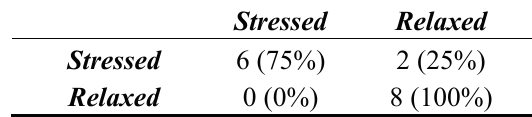
Table 6. Confusion matrix based on the fusion based classification.